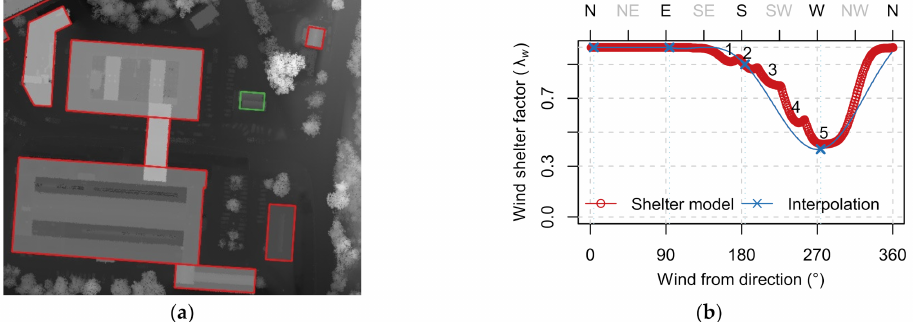
Figure 23. Air infiltration sheltering for the NTNU Living Lab (ZEBLL) case ( a ) Upwind obstacle geometries in red (OSM building footprints) and building exterior facades in green overlaid on the local DSM height map by Kartverket/CC-BY 4.0; ( b ) The combined directional shelter factor for the four facades using the shelter model (red) and the table-values obtained for each building side (blue).